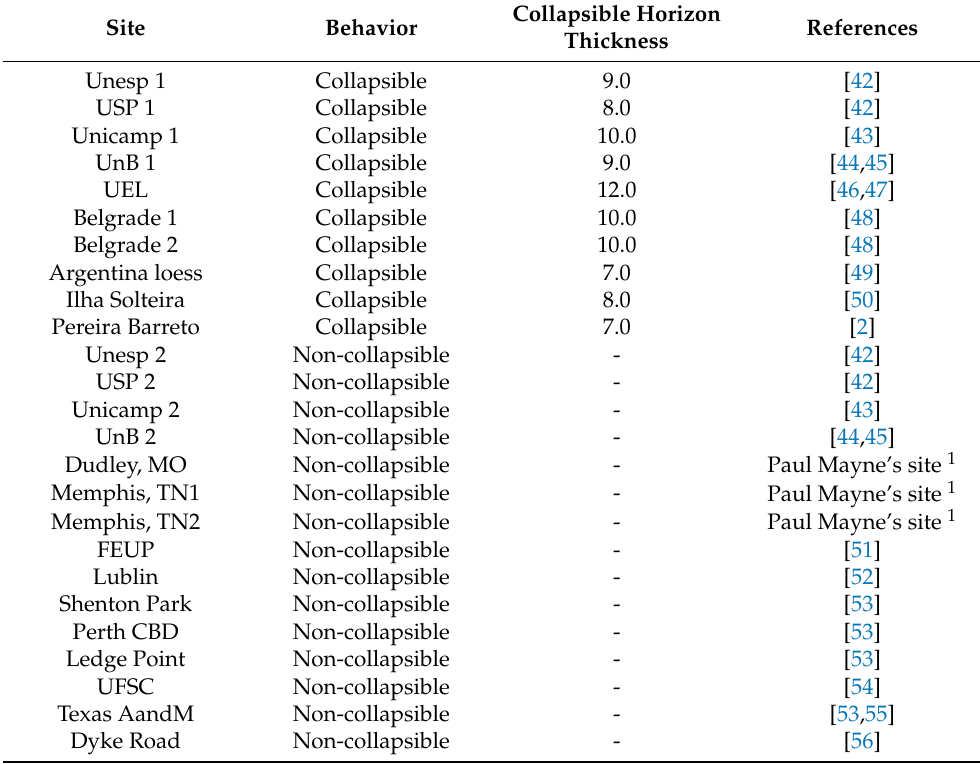
Table 1. Site designation, collapsible behavior, and references for the soils from each site.